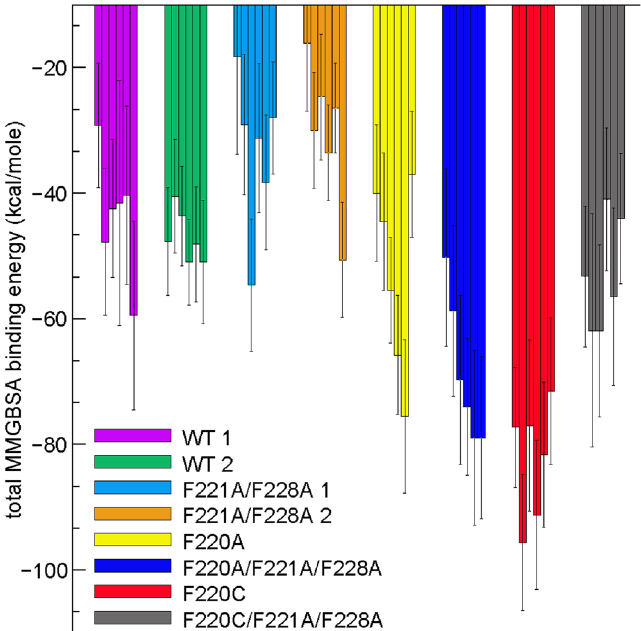
Figure 6. Binding energies of dimerization, quantified with the MMGBSA approach, for different opsin constructs. The MMGBSA binding energies are plotted for the following systems: two WT constructs (Mode 1 and Mode 2 WT), F220A and F220C single mutants, the two F221A/F228A double mutants (the mutations introduced into Mode 1 and Mode 2 WT models), as well as for F220A/F221/F228A and F220C/F221/F228A triple mutants (F221A and F228A mutations introduced into the F220A and F220C models, see Methods for more details). The MMGBSA calculations were performed as described in Methods. Data for six independent replicates per construct are shown separately. For each system, 25–150 ns time-intervals of the trajectories were considered for this analysis. The error bars were estimated using the approach based on determination of the effective sample size for autocorrelated data described by Chodera and co-workers 64 . See also Table